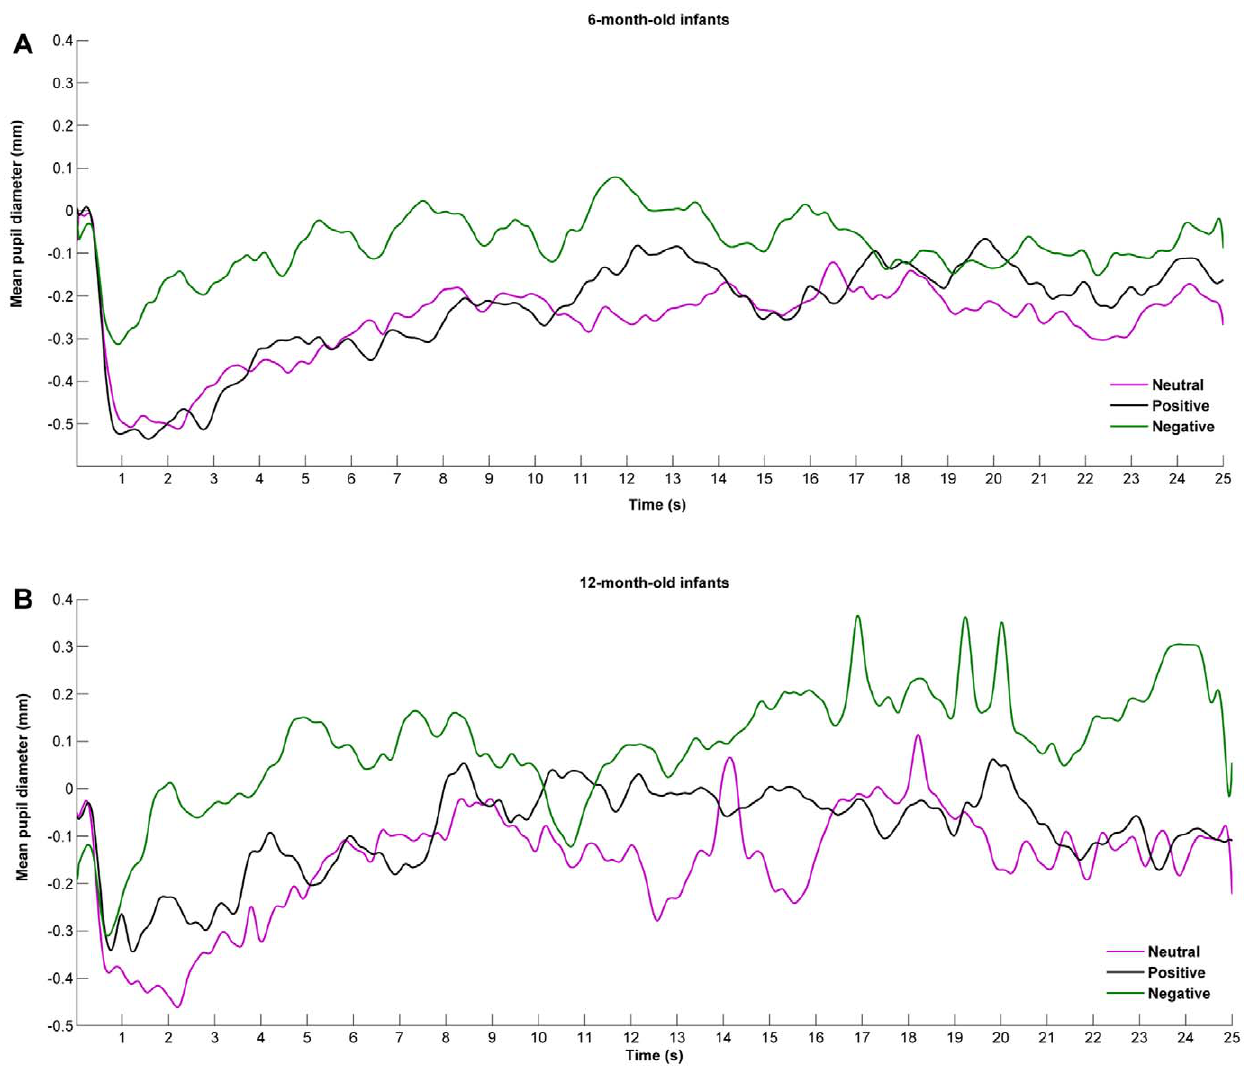
Figure 1. Mean functional change in pupil diameter for each type of stimulus. After filtration and interpolation, the pupil measurements from both eyes were averaged. Baseline-correction was performed by subtracting the mean pupil diameter from the last one second of the preceding inter-trial from each data point recorded during the stimulus presentation. The change in pupil size from baseline for the neutral (purple line), positive (black line), and negative (green line) stimulus is presented separately for 6- (A) and 12-month-old infants (B).